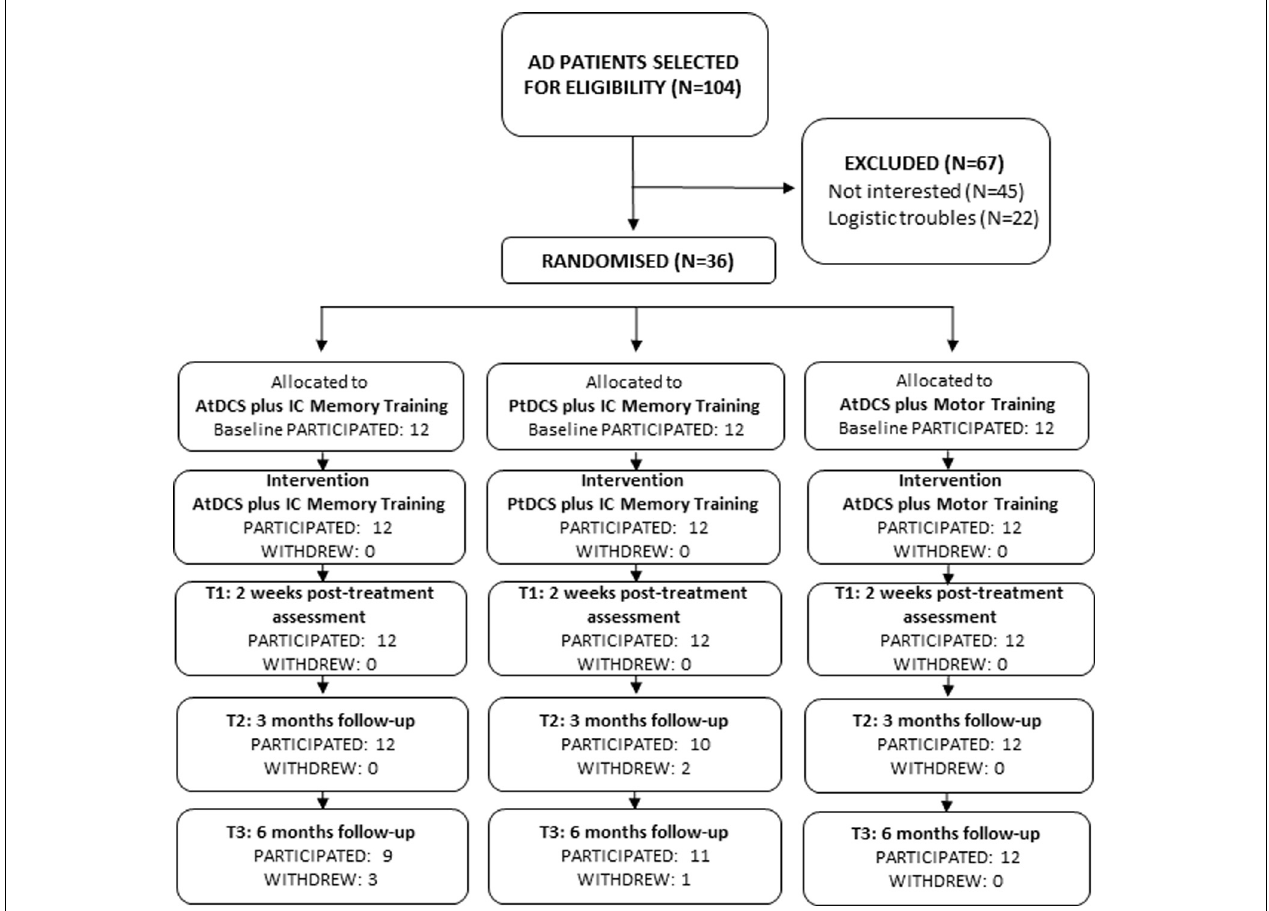
FIGURE 1 | Flow diagram of progression of participants through the